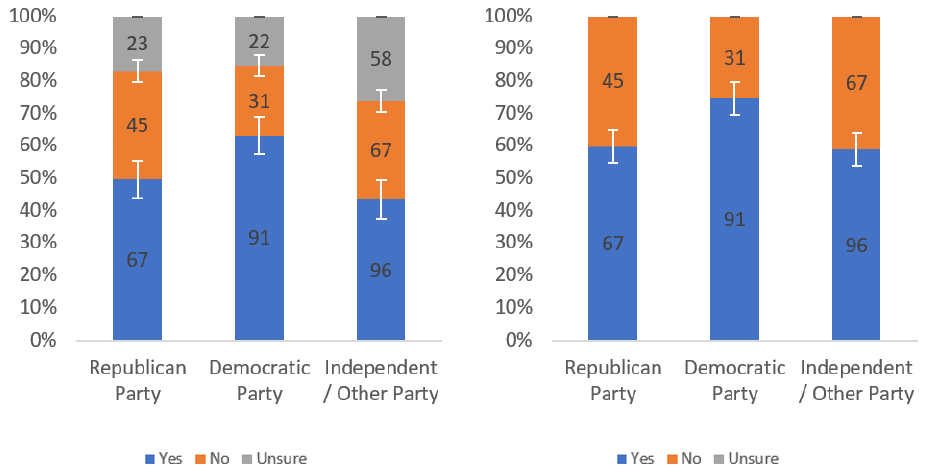
Figure A29. Responses regarding usefulness in judging trustworthiness by party affiliation including ( left ) and excluding ( right ) unsure responses.